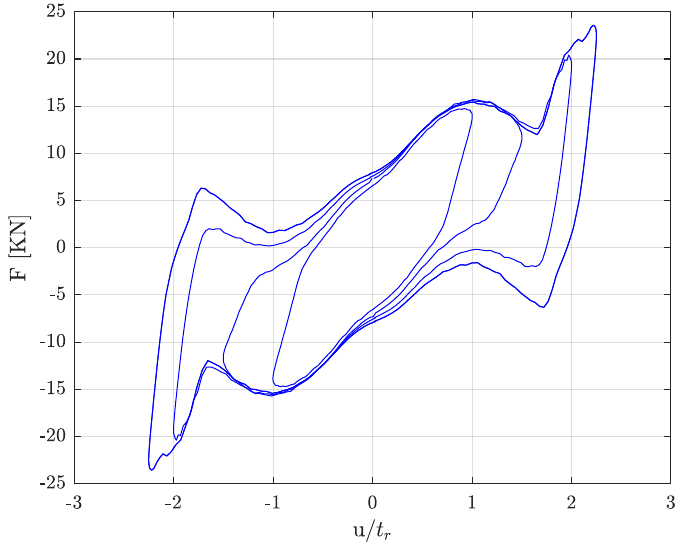
Figure 18. Force-displacement curve for